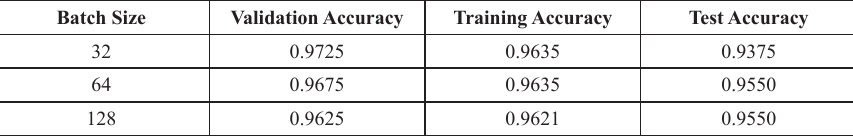
Table 8. Accuracy of different batch sizes on validation, train, and test